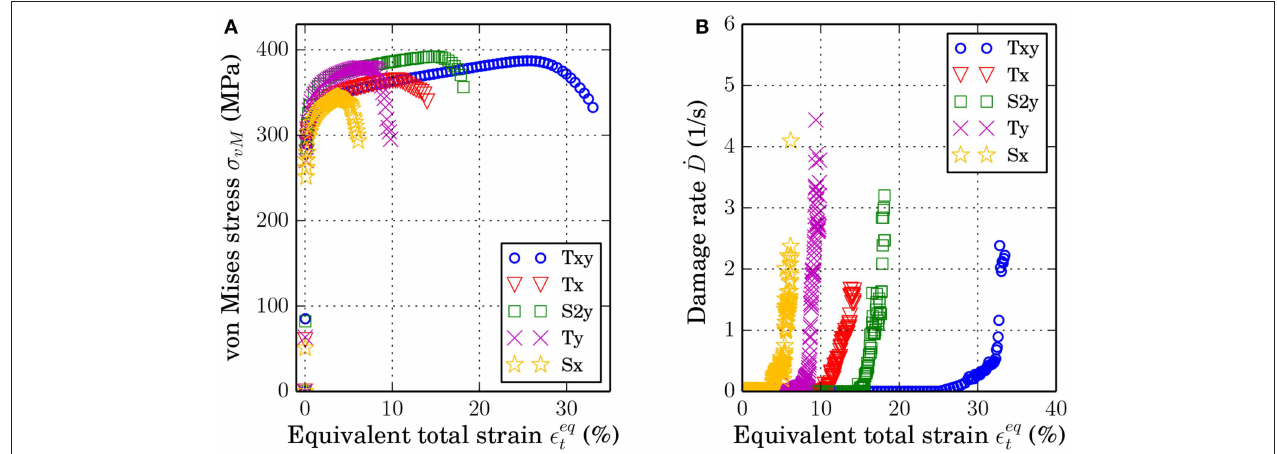
FIGURE 5 | Global data plots for uniaxial tension in x- and y-direction (Tx, Ty), biaxial tension (Txy), and shearing in x- and y-direction (Sx, S2y): (A) von Mises stress plotted against the total equivalent strain, (B) Damage rate as a function of the total equivalent strain.